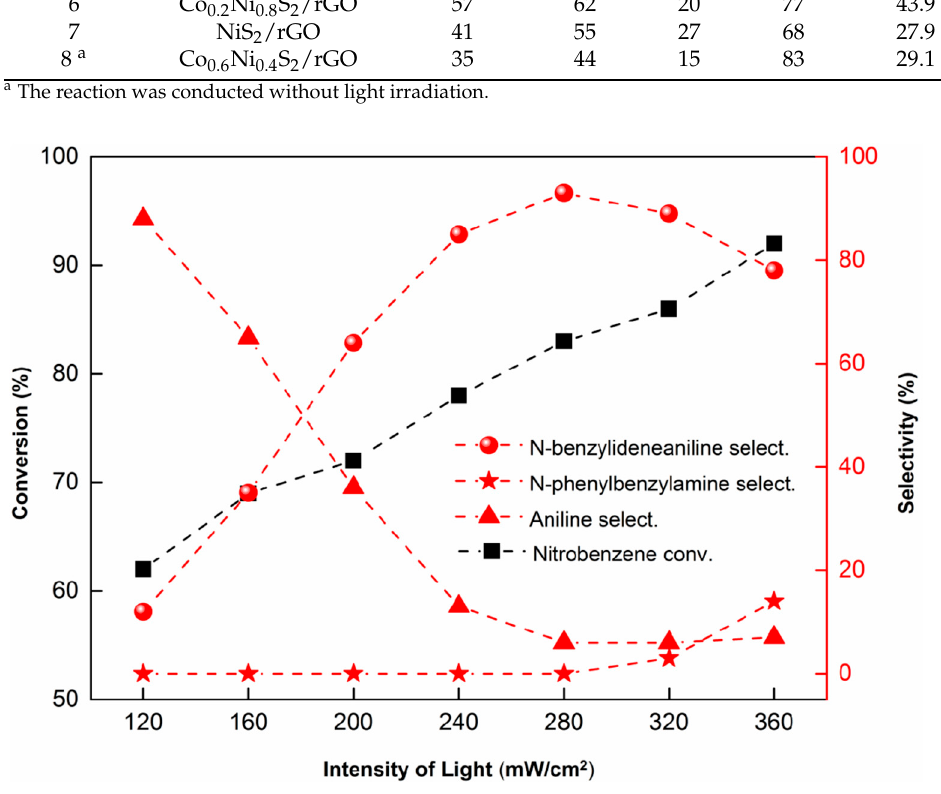
Figure 5. The dependence of photocatalytic activity for N -benzylideneaniline synthesis on the irradiation intensity over Co 0.6 Ni 0.4 S 2 /rGO.